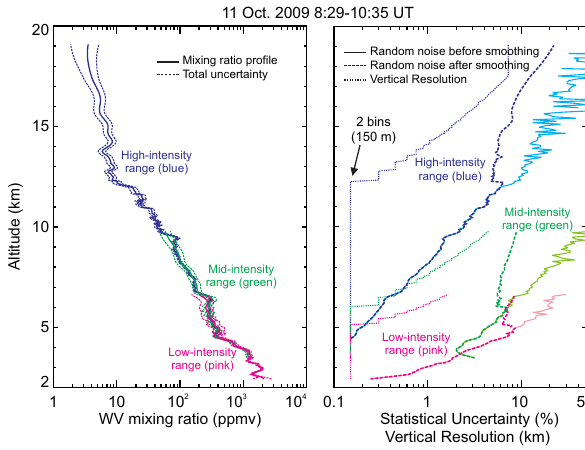
Fig. 3. Example of the effect of vertical filtering on the TMW water vapor profiles. Left plot: mixing ratio profiles for all three ranges (pink: low-intensity, green: mid-intensity, and blue: high-intensity range). Right plot: statistical uncertainty (%) before (solid curves) and after (dashed curves) filtering, and corresponding vertical reso- lution (km) (dotted curves) following the definition based on digital filter cutoff